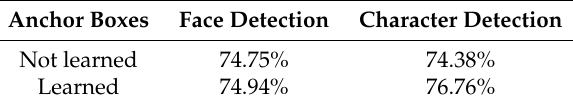
Table 8. Comparison between face and character detections from panels on the DCM772 dataset with two settings: with and without learned anchor